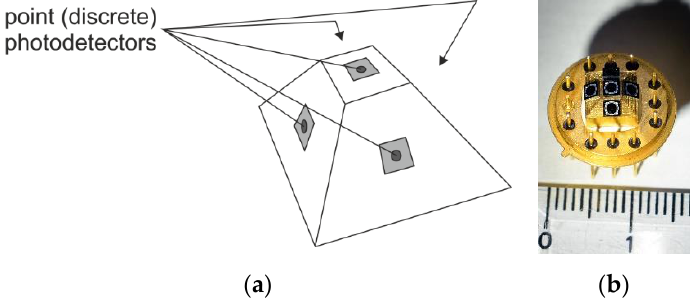
Figure 3. ( a ) Idea of an angle-of-incidence (AOI) sensor based on five discrete detectors bonded to a pyramidal geometry. ( b ) Photo of such a sensor developed by our team [8].